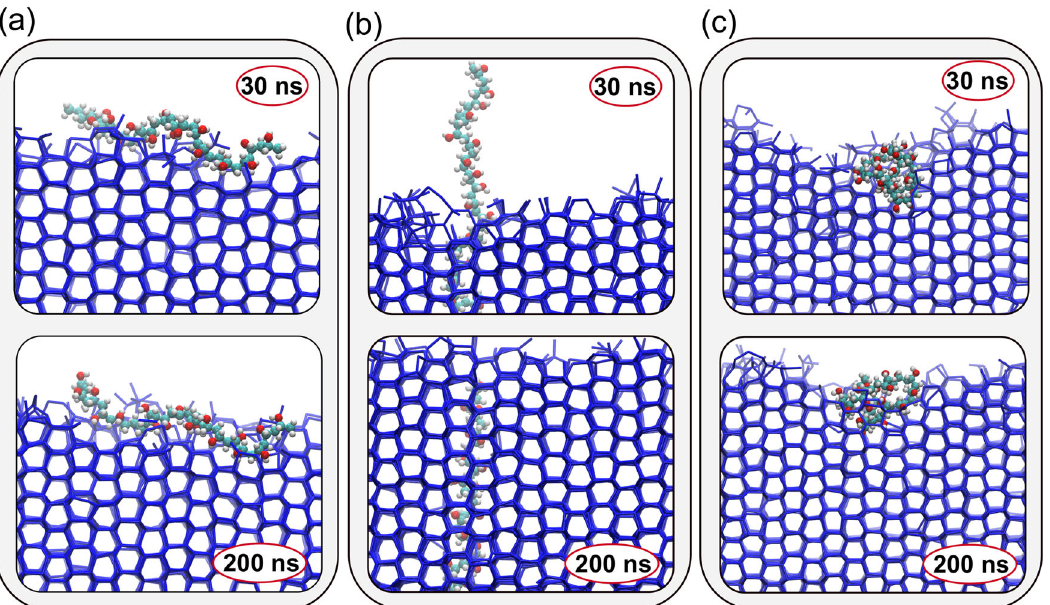
Fig. 3 Lattice matching is not a prerequisite for PVA to bind to ice. Representative snapshots of PVA 20 binding on a growing ice crystal. a An extended PVA chain ( R g ~ 1) is restrained so as to be perpendicular with respect to the growing ice front. b A similarly extended conformation is restrained so as to be parallel with respect to the growing ice front. c A compact, globular conformation ( R g ~ 0.5). All three conformations can bind ice, but only those illustrated in panels a and c show sustained IRI activity. Only water molecules belonging to the ice phase are